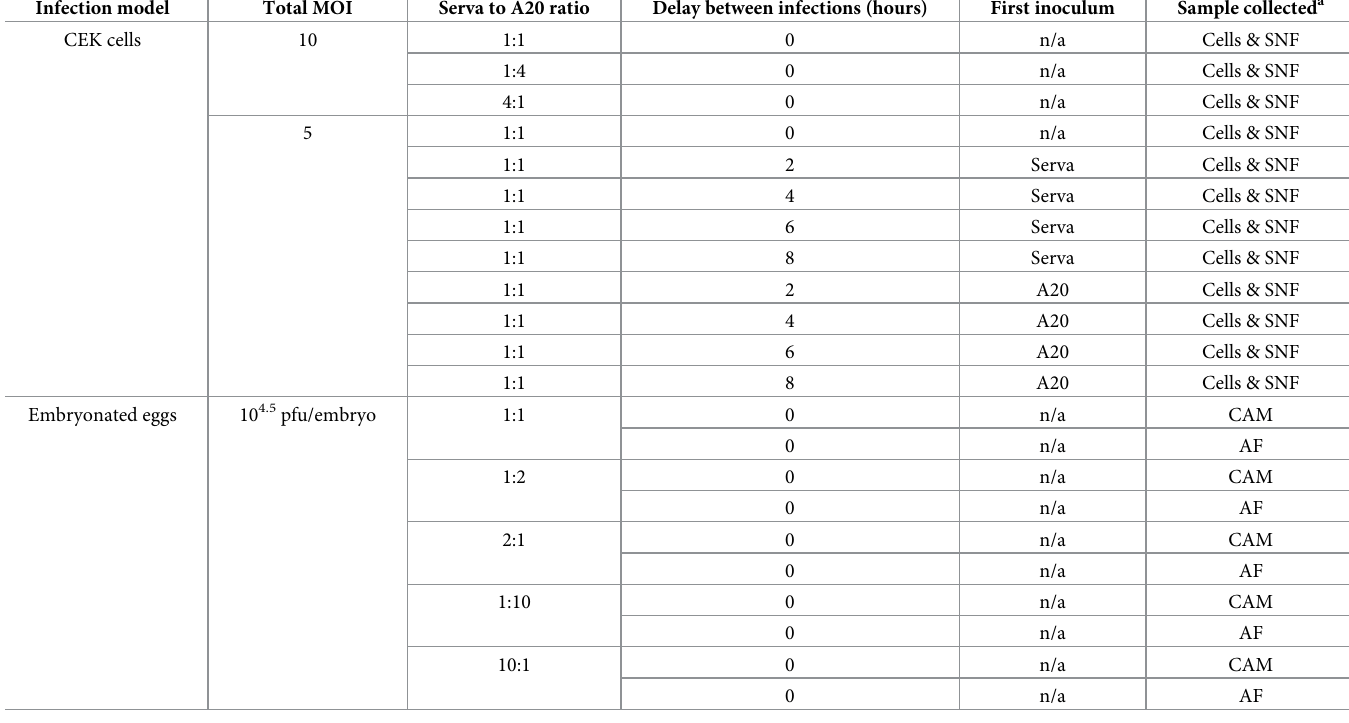
Table 1. Summary of inocula used and the samples collected. Infection model